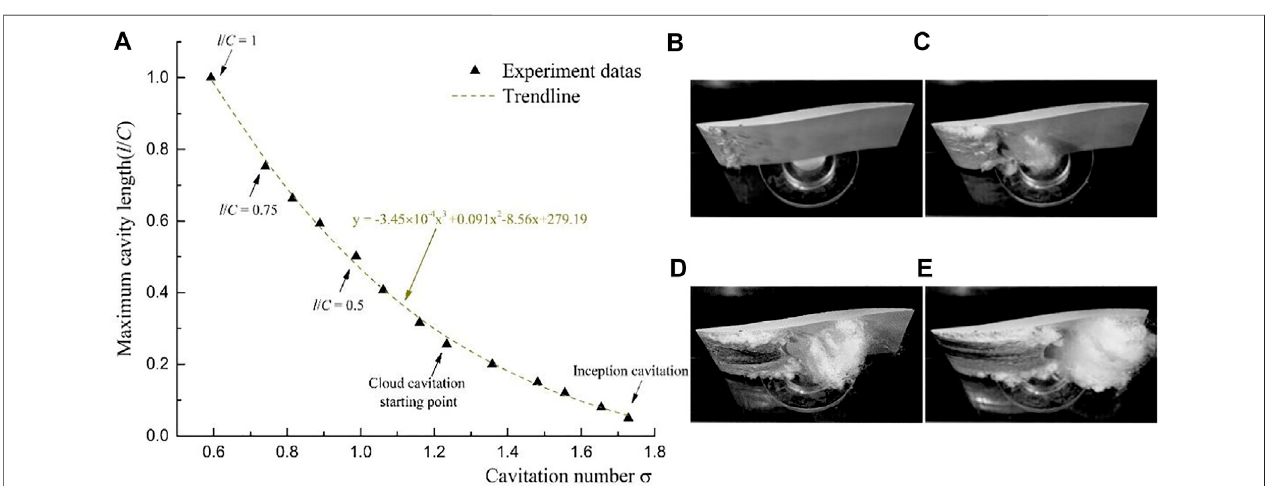
Frontiers in Energy Research |